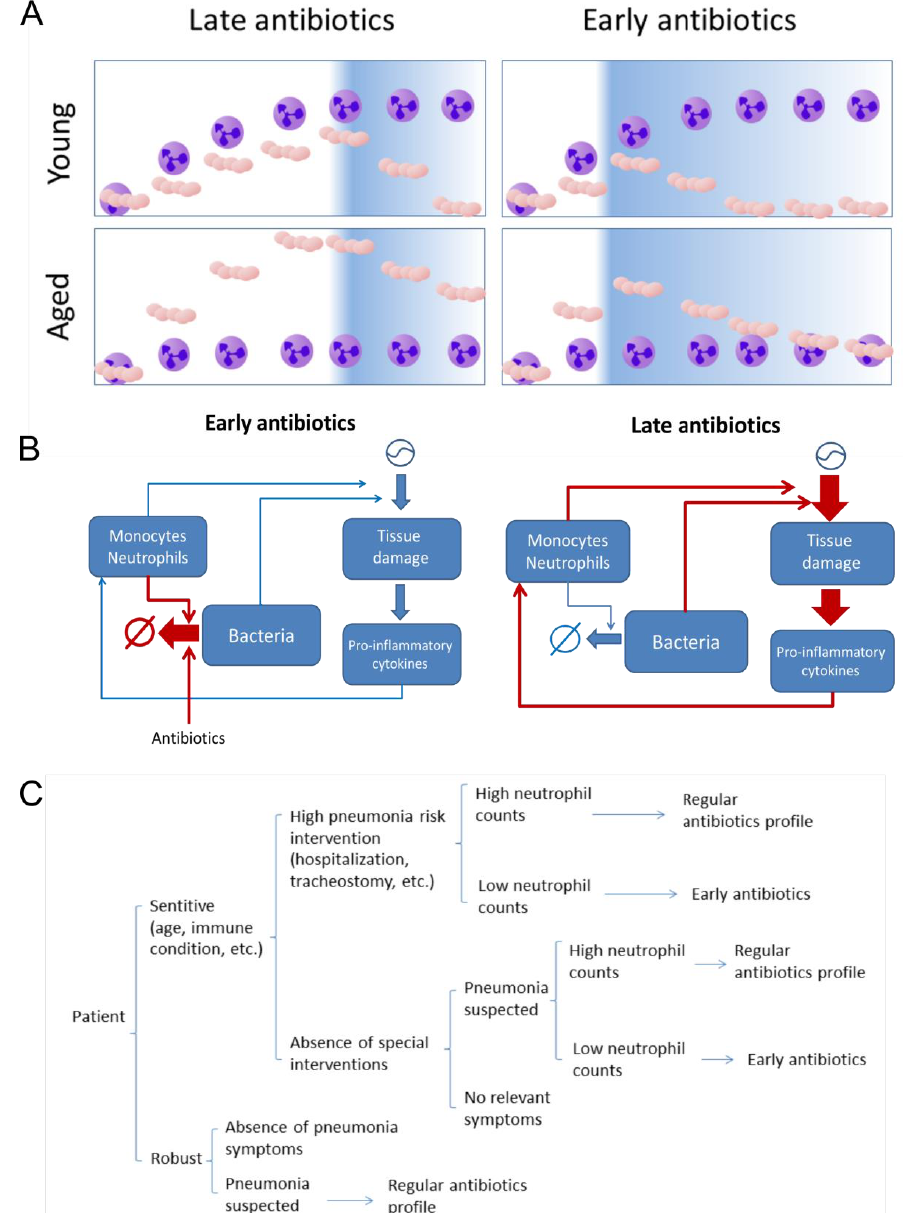
Figure 5. ( A ). Graphical representation of the effect of early antibiotic administration on bacteremia under the two different age scenarios (purple cell: neutrophils, beige cocci: S. pneumoniae ). ( B ). The hypotheses derived from the simulations is that under late antibiotics administration, sustained bacteremia levels induce concomitant long-lasting tissue damage and inflammation, which activates later cytokine-mediated feedback loops promoting unresolved inflammation (not shown in the simulations). Under early antibiotics administration, the bacteremia and tissue damage never reach the levels and duration necessary to trigger the sustained feedback activation. ( C ). Sketch of a possible decision tree for a personalized treatment of pneumonia based on neutrophil count.